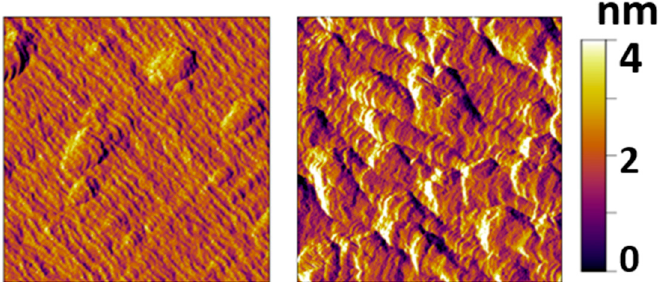
Figure 4. AFM amplitude images of 5 × 5 µ m of InGaN grown at 820 ◦ C ( left ) (In = 16.5%) and 800 ◦ C ( right ) (In = 19.8%). The samples were grown with a Cp 2 Mg flow of 48 nmol/min.